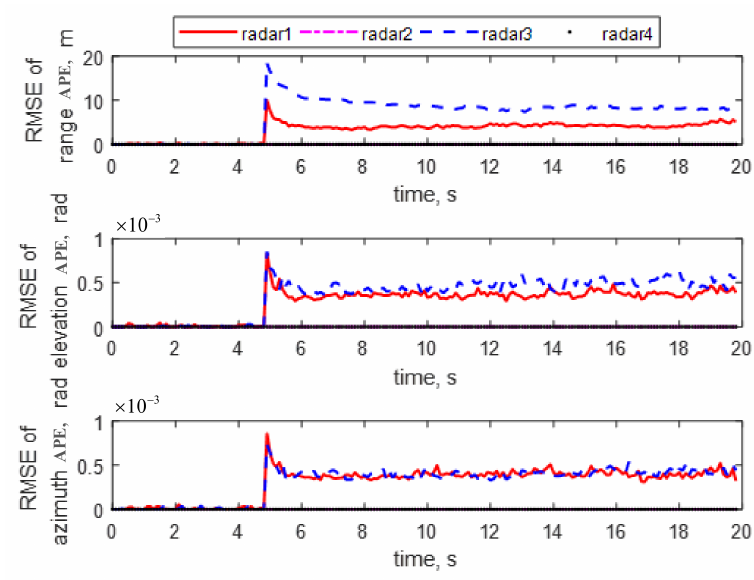
Figure 7. RMSE of the attack parameter estimations for radars